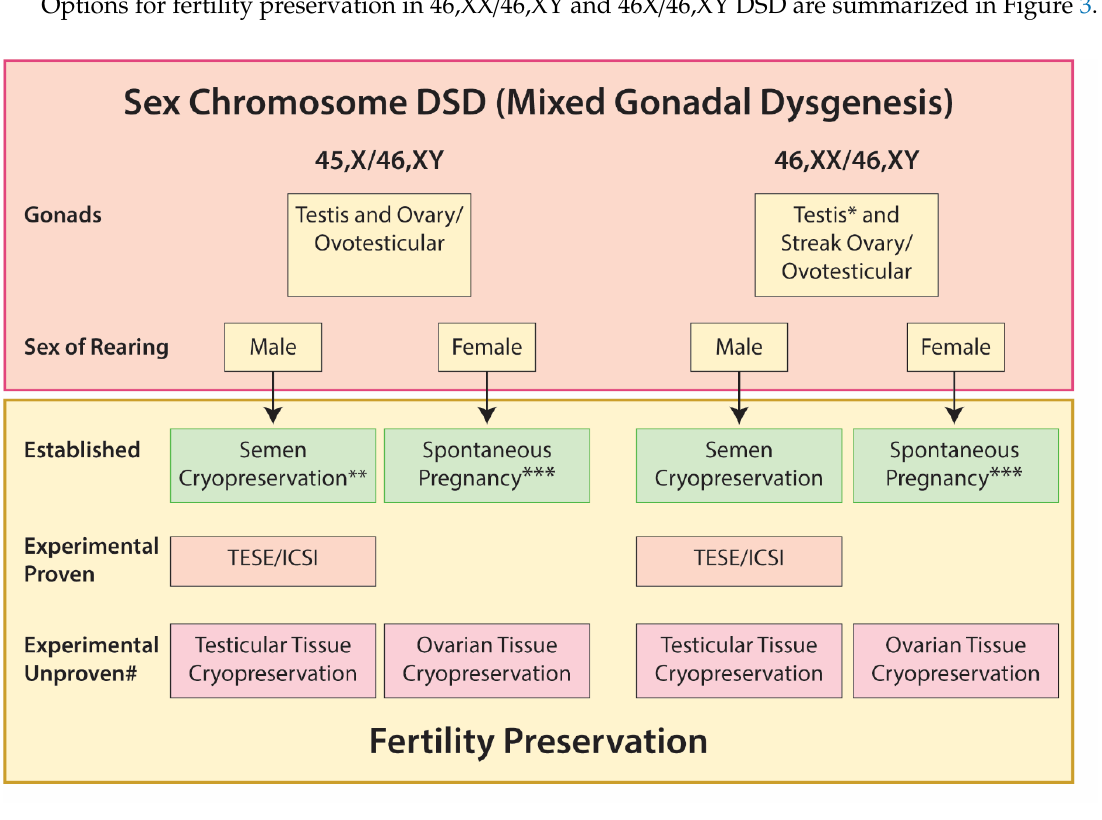
Figure 3. Options for fertility preservation in sex chromosome DSD (mixed gonadal dysgenesis). *